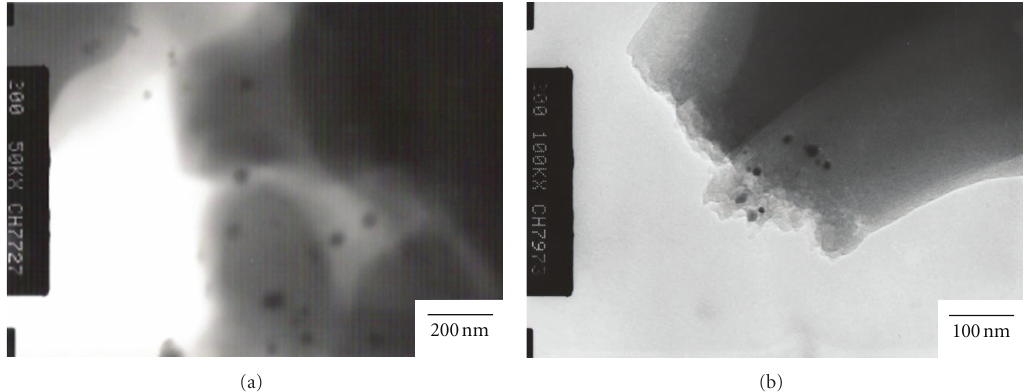
Figure 4: TEM image of (a) the heat-treated (Sample 2) and (b) the as-prepared (Sample 3)